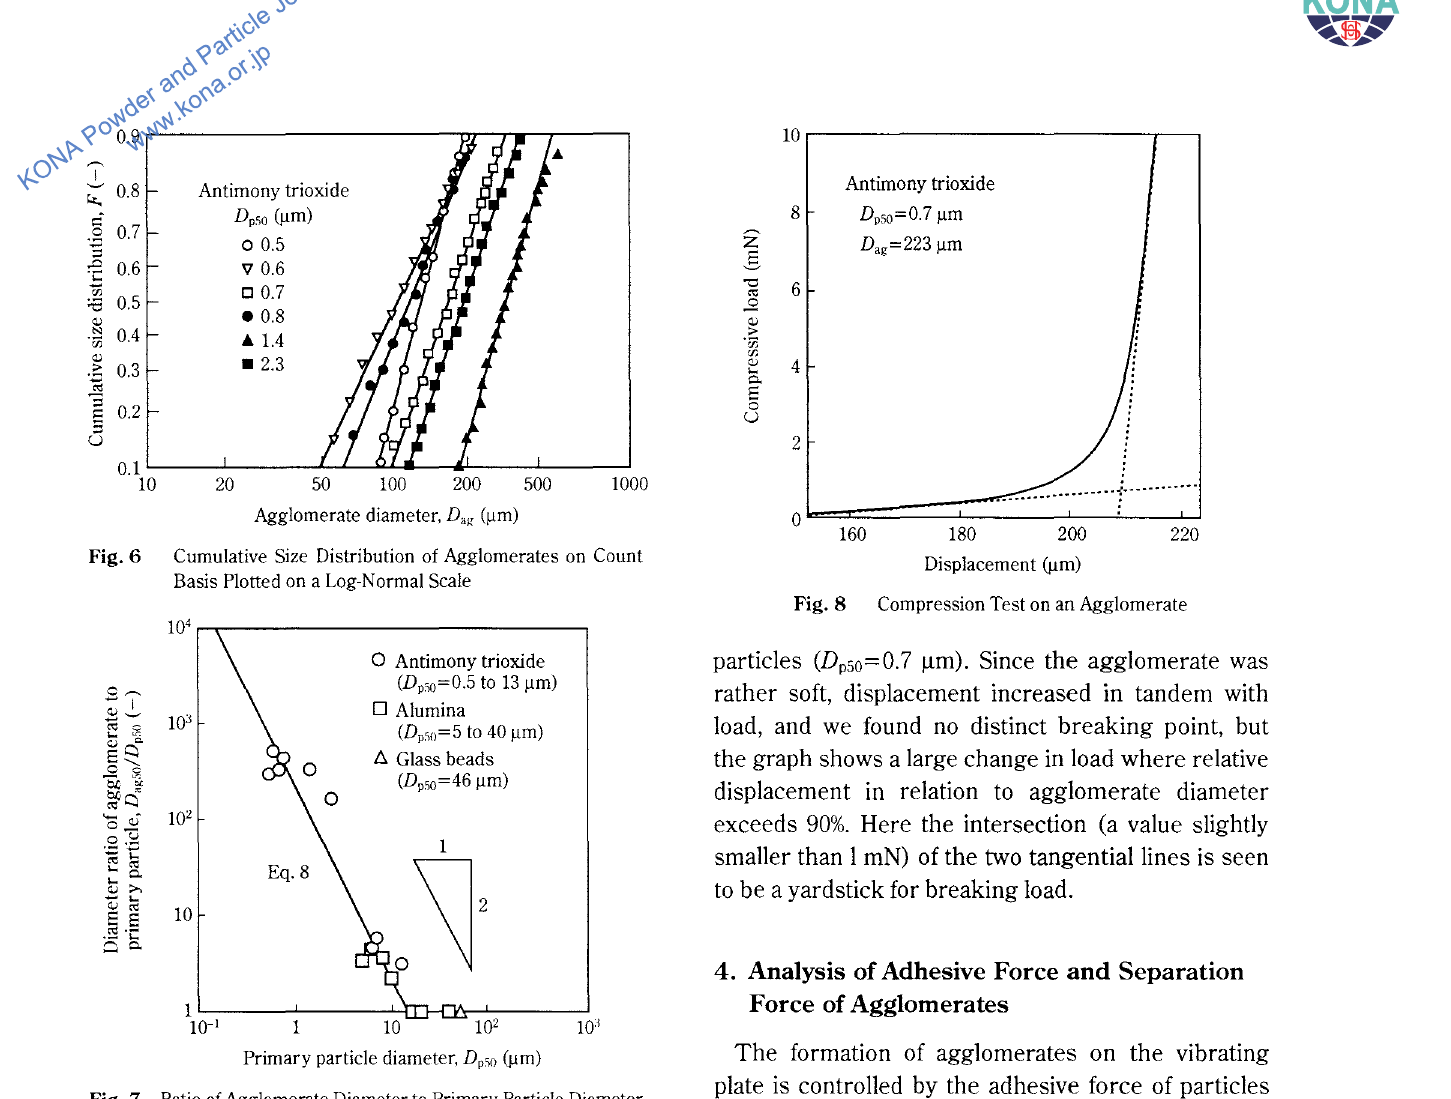
Fig. 7 Ratio of Agglomerate Diameter to Primary Particle Diameter